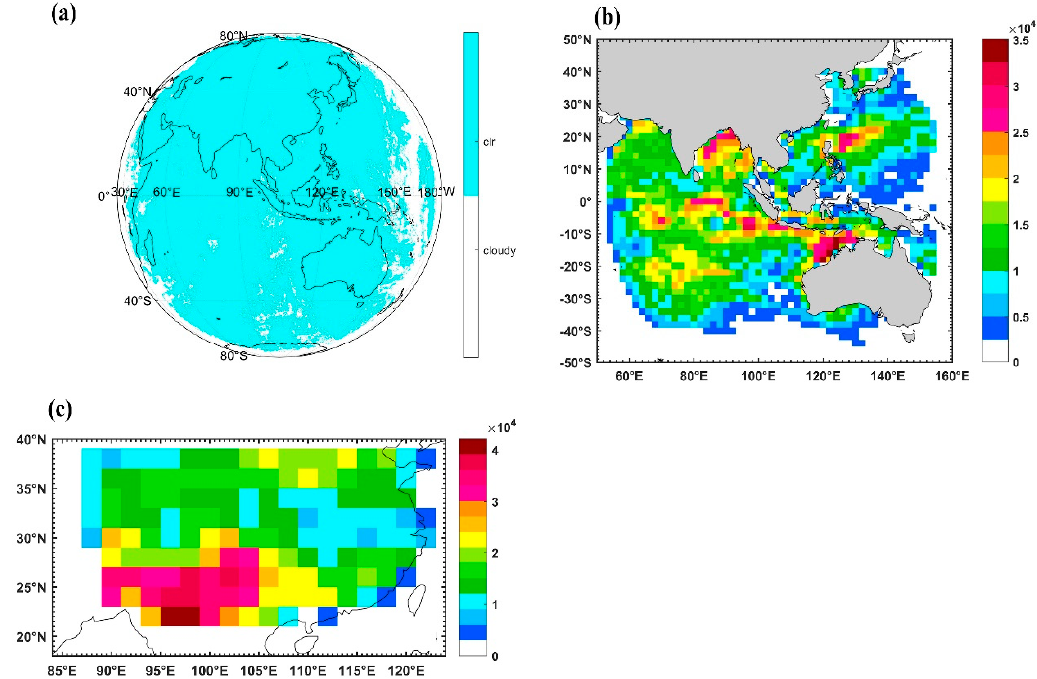
Figure 3. ( a ) Composite map of areas with at least one clear sky pixel (cyan) or no clear pixel (white), ( b ) total clear–sky pixels counts over ocean and ( c ) selected land area (20°N~40°N, 85°E~125°E) within the 2–degree grid of the 10 days: 1–3 September and 1–3 December 2017, as well as 1–2 March and 1–